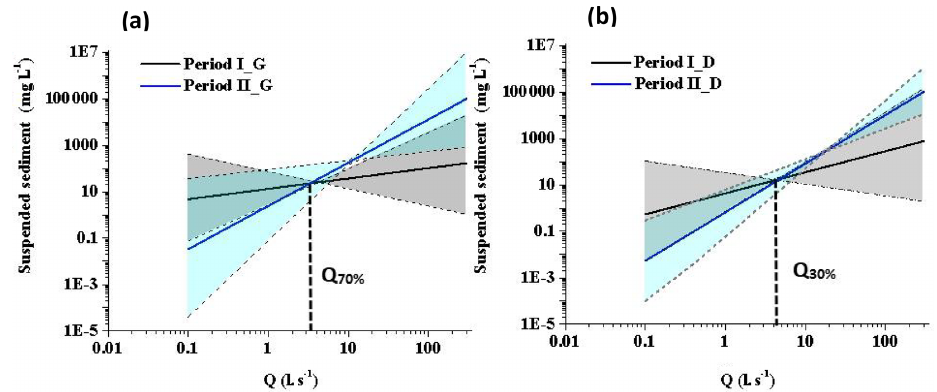
Figure 7. Theoretical sediment rating curves (tSRCs) for the growing seasons (a) and the dormant seasons (b) of Period I and Period II. Solid lines denote the 50th percentile of the tSRCs for each period (i.e., tSRC 50% ). The gray area denotes the range of the predicted tSRCs composed of the 5th and 95th percentiles (i.e., tSRC 5% and tSRC 95% , respectively). Q 30% and Q 70% represent the flow conditions of 3.9Ls − 1 and 2.0Ls − 1 , respectively.